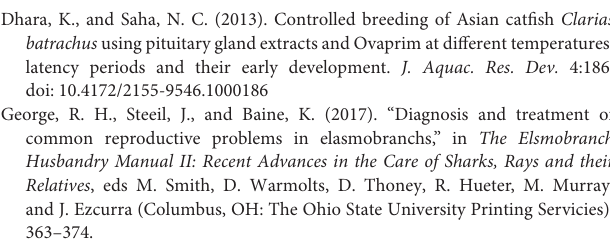
was injected at 0.2 mL/kg dose at the orange arrowed time point. (B) Average hormone concentration changes of female T. scyllium . Ovaprim R (cid:13) was injected at 0.6 mL/kg dose at the orange arrowed time points. (C) Average hormone concentration changes of T. scyllium (Female #3; F003). Ovaprim R (cid:13) was injected at 0.6 mL/kg dose at the orange arrowed time point. (D) Average hormone concentration changes of male T. obesus . Ovaprim R (cid:13) was injected at 0.2 mL/kg dose at the orange arrowed time point. (E) Average hormone concentration changes in female T. obesus . Ovaprim R (cid:13) was injected at 0.2 mL/kg and 0.3 mL/kg doses in serial at the orange arrowed time points. Figure 4 . Ovarian follicle size change after Ovaprim R (cid:13) injection in Triakis scyllium and Triaenodon obesus. (A) Ovarian follicle size changes after Ovaprim R (cid:13) injection in female T. scyllium . Axis length and area values were measured directly on ultrasonography. Eccentricity was calculated with the long and short axis values. The orange arrows indicate the time points of Ovaprim R (cid:13) administration. (B) Ultrasonography of left ovary before Ovaprim R (cid:13) injection in T. scyllium (F003). The orange arrows indicate the same follicle in (C) at different time point. Size of the follicle with the orange arrow was 3.7 cm × 1.9 cm (5.45 cm 2 ). (C) Ultrasonography of left ovary after Ovaprim R (cid:13) injection in T. scyllium (F003). Follicles showed distinct size increase. The orange arrows indicate the same follicle in (B) at different time point. Size of the follicle with the orange arrow was 4.9 cm × 2.0 cm (7.60 cm 2 ). (D) Ovarian follicle size changes after Ovaprim R (cid:13) injection in female T. obesus . Axis length and area values were measured directly on ultrasonography. Eccentricity was calculated with the long and short axis values. The orange arrows indicate the time points of Ovaprim R (cid:13) injection. (E) Ultrasonography of left ovary before Ovaprim R (cid:13) injection in WF002 ( T. obesus ). The orange arrows indicate the same follicle in (F) at different time point. Size change of the follicles can be recognized by ultrasonography. Size of the follicle with the orange arrow was 4.4 cm × 3.0 cm (10.27 cm 2 ). (F) Ultrasonography of left ovary after Ovaprim R (cid:13) injection in WF002 ( T. obesus ). The orange arrows indicate the same follicle in (E) at different time point. Size of the follicle with the orange arrow was 7.4 cm × 3.7 cm (21.77 cm 2 ). Figure 5 . Schematic graph of dose optimization in Triakis scyllium and Triaenodon obesus . A conceptual graph showing the correlation between biological phenomena (x-axis) and artificial insemination suitability (y-axis) that change depending on the total dose of Ovaprim R (cid:13) administered. The shaded area